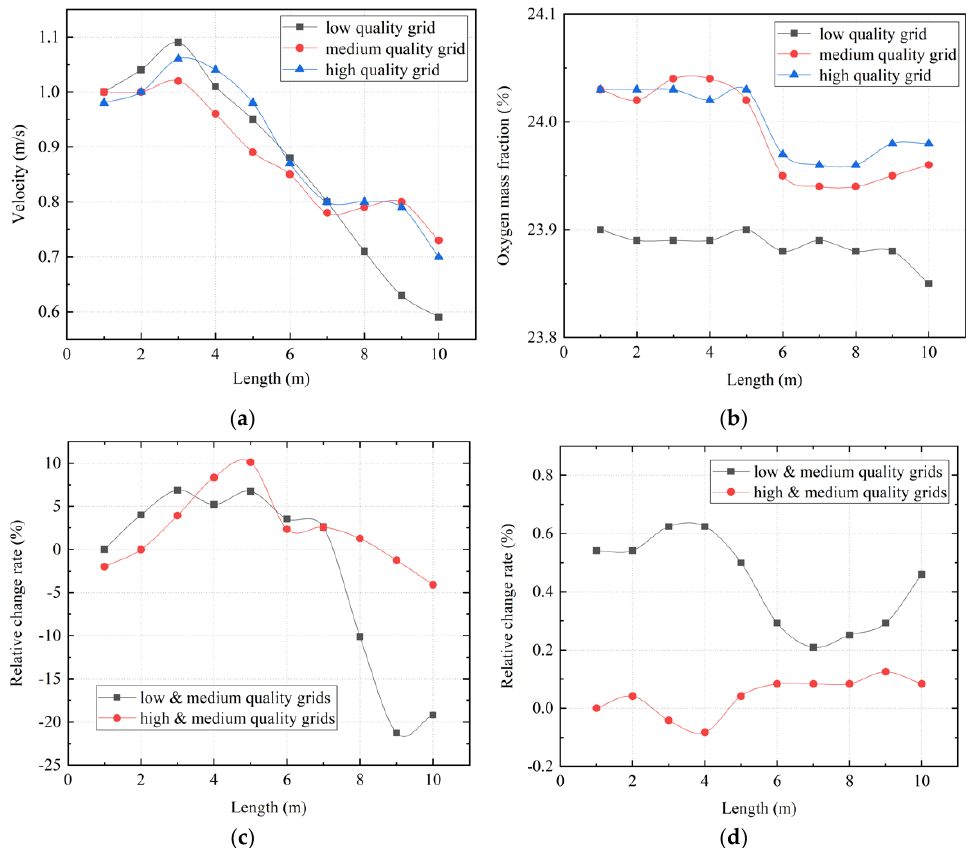
Figure 4. Grid independence analysis. ( a ) Wind speed distribution along the roadway; ( b ) oxygen mass fraction distribution along the roadway; ( c ) relative change rate in wind speed; ( d ) relative change rate in oxygen mass fraction.